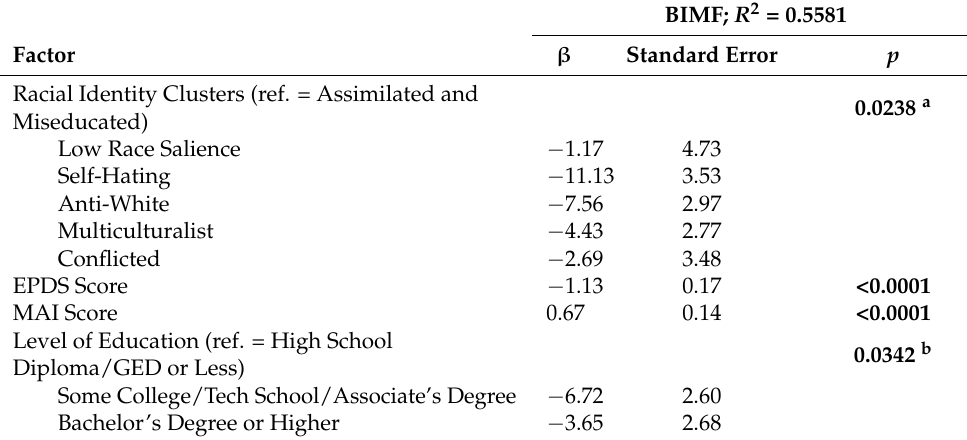
Table 3. Multivariate analyses to assess factors independently associated with the maternal function- ing ( n =